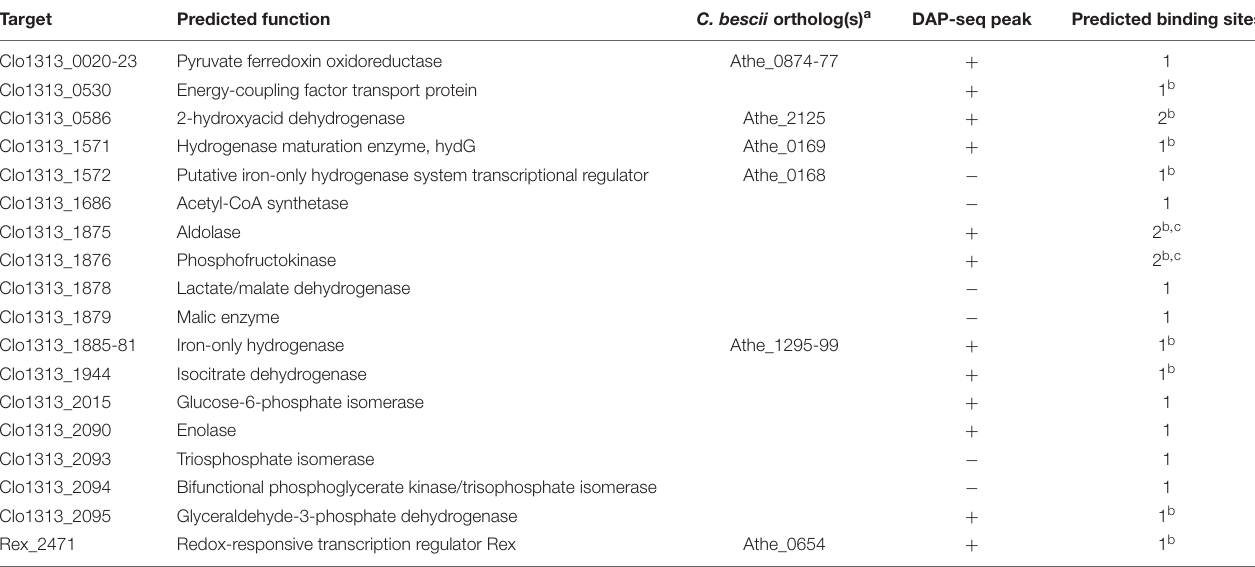
TABLE 4 | Highlights of the Rex_2471